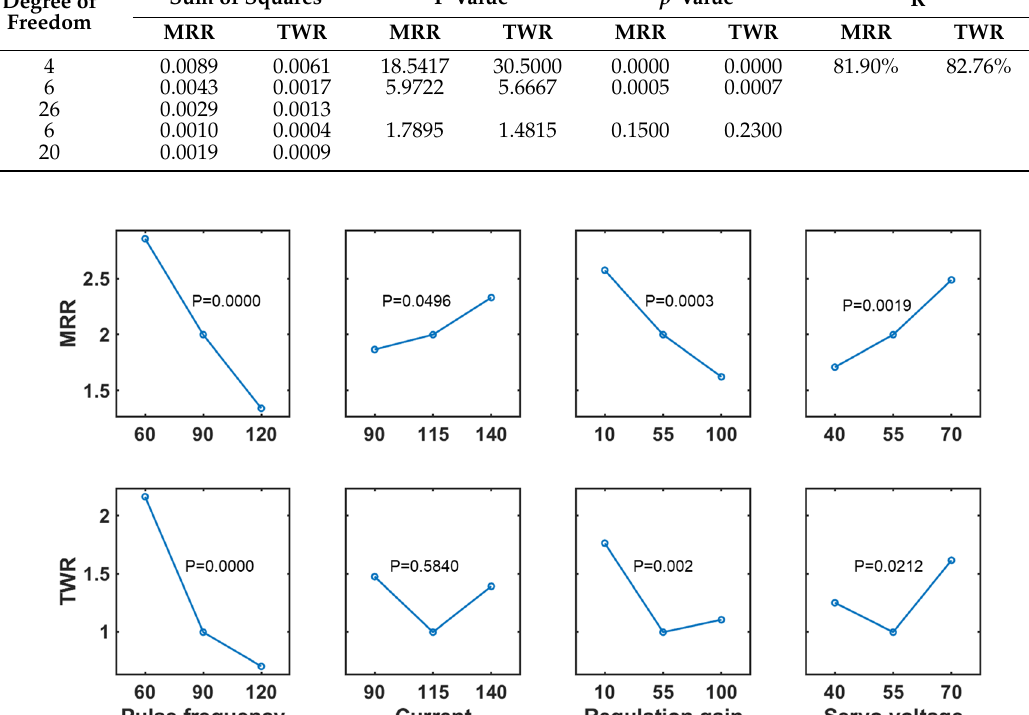
Figure 4. The main effect estimate of input factors, i.e., the pulse frequency, current, regulation gain and servo voltage with respect to the MRR and TWR responses. The p -value from the ANOVA analysis is given on top of each plot to illustrate the significance of each parameter.